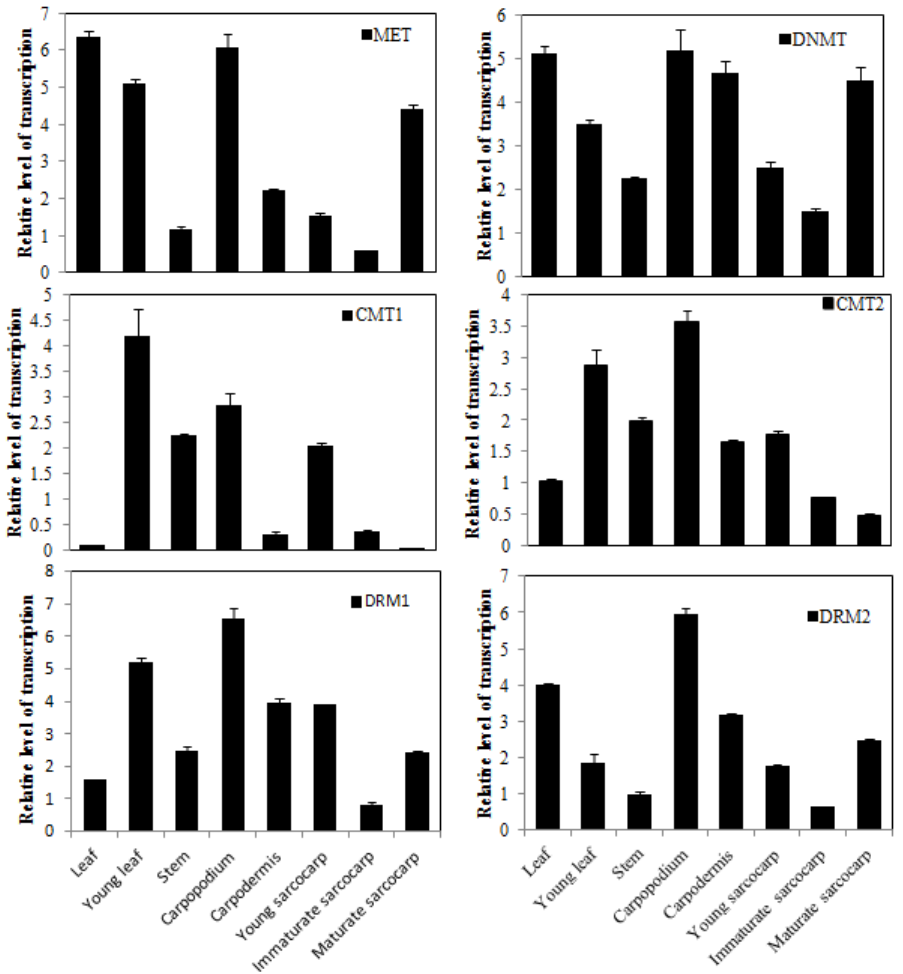
Figure 6. Expression profiles of AcC5-MTase genes in different tissues of pineapple. Values represent the average of three biological replicates, and vertical lines represent the SD of the average.